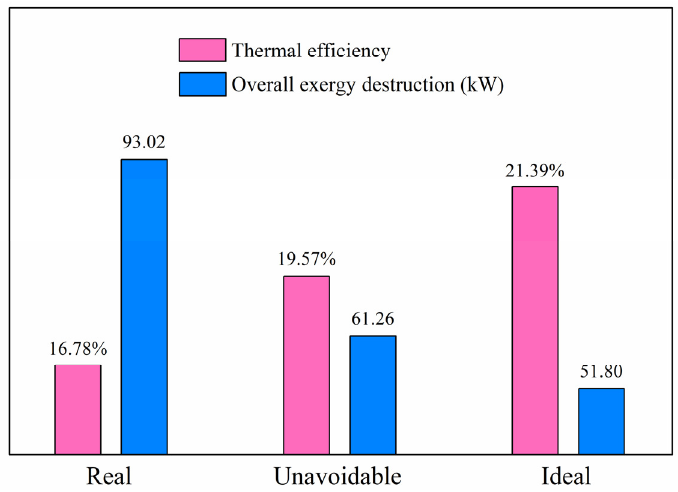
Figure 8. Thermal efficiency and overall exergy destruction for different conditions.